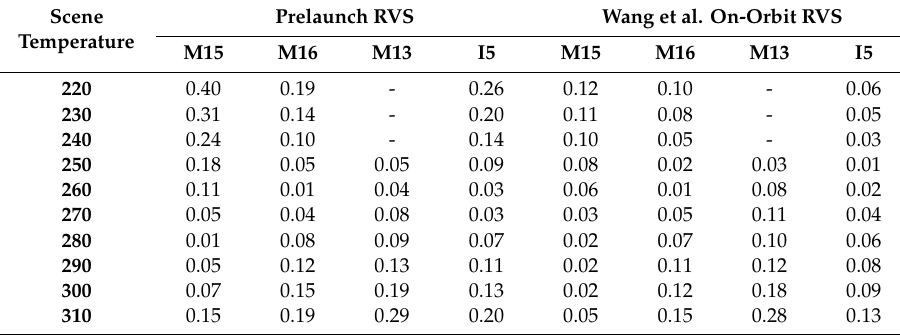
Table 5. NOAA-20 VIIRS–CrIS scan averaged biases at 10 scene temperatures for the NOAA operational (prelaunch RVS) and the reprocessed SDRs (the Wang et al. method derived on-orbit RVS). Unit for scene temperatures and biases: